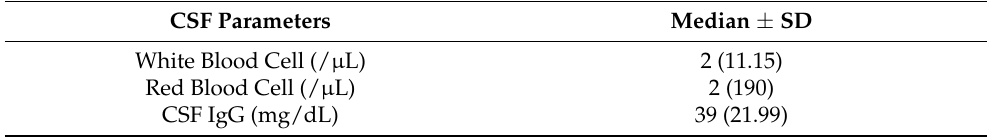
Table 2. Cerebrospinal fluid analysis of 372 MS